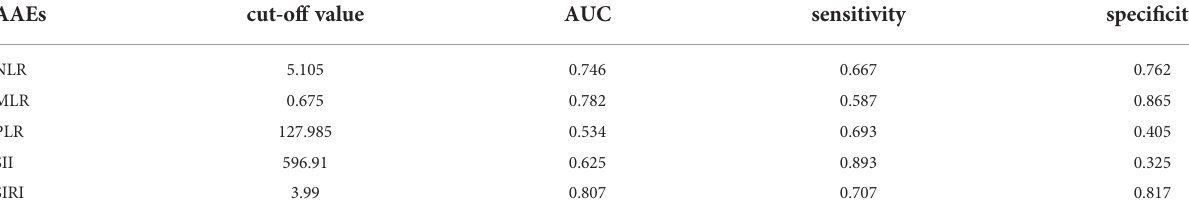
TABLE 2 Receiver operating characteristic curve